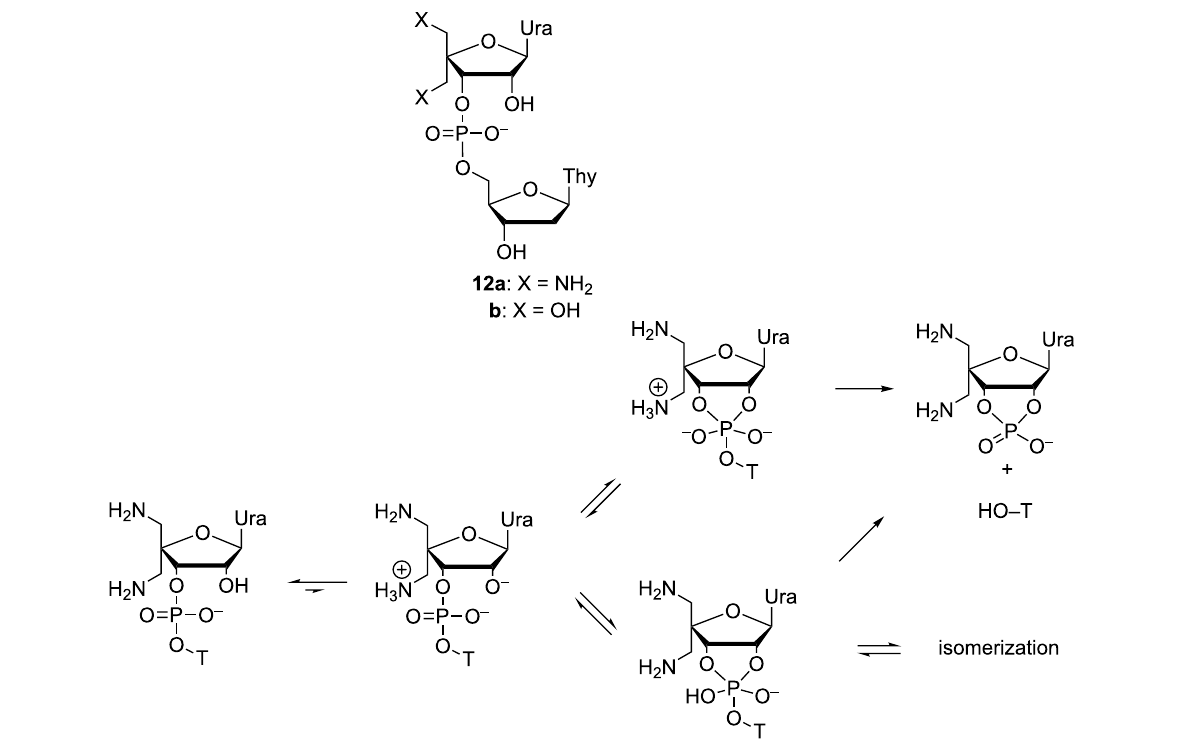
Scheme 9: Mechanism for the pH-independent cleavage and isomerization of model compound 12a in the pH-range 7.5–8.5